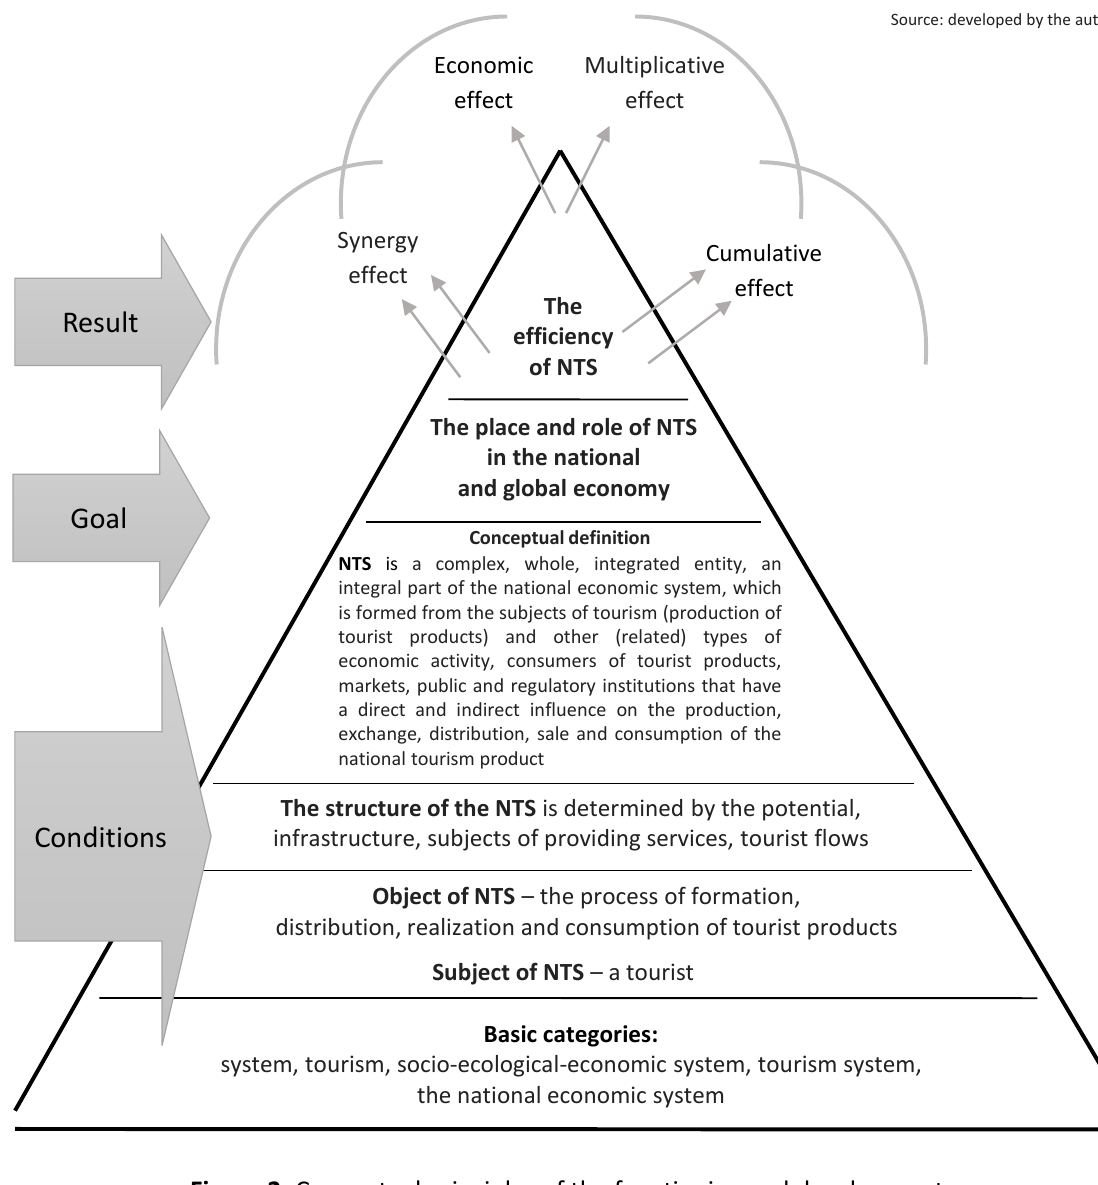
Figure 2. Conceptual principles of the functioning and